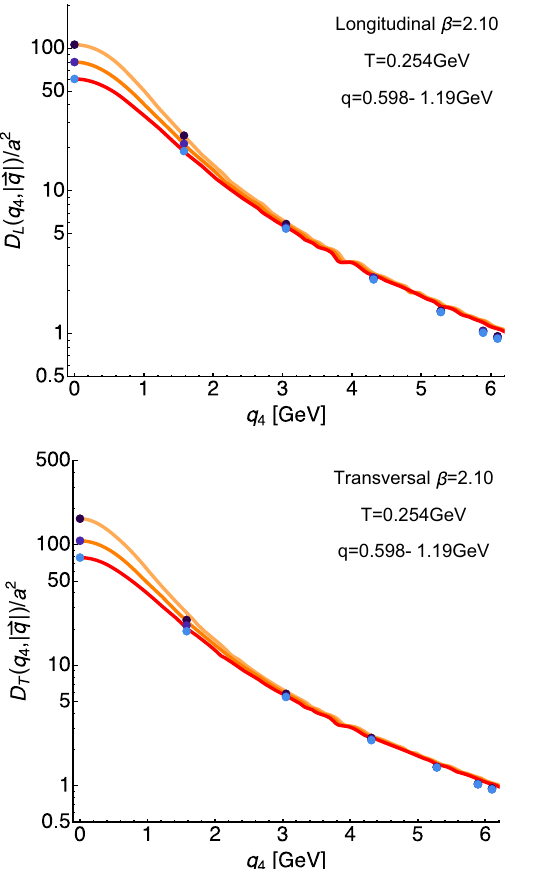
in order to reproduce the finite imaginary frequency behavior of the propagator (blue points). The solid curves show the O ( 4 ) evaluation (cid:23) ˜ D ( + | q | 2 ) . We can see that, while for small imaginary fre- q 2 L / T 4 quencies the O ( 4 ) ansatz works quite well, it starts to degrade as one approaches the boundary of the Brillouin zone due to breaking of rota- tional symmetry on the ( | q | ) L / T